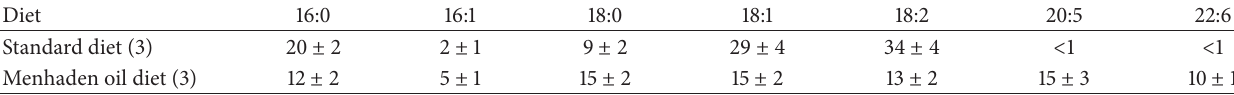
Table 2: Fatty acid % composition of diets measured by gas